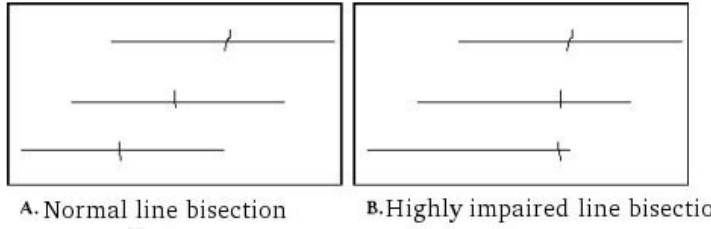
Figure 2. For the line bisection test, the middle of the line has to be indicated ( A ). A bias towards one of the extremities of the line can be an indication of USN ( B ).